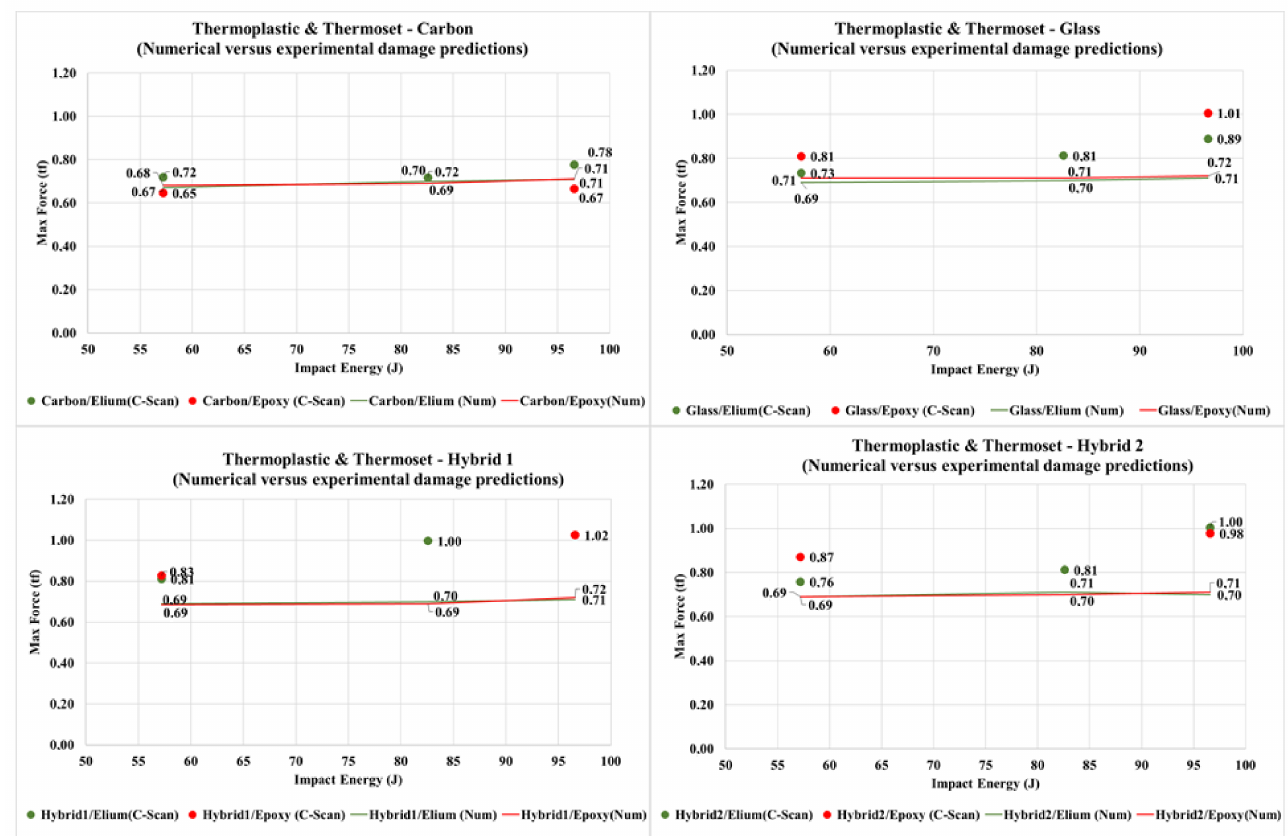
Figure 21. Numerical vs. experimental maximum force measurements as function of impact energy levels for different fiber and resin